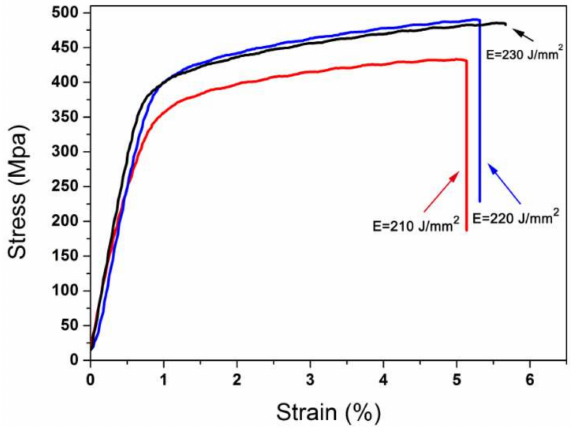
Figure 3. Tensile stress-strain cures of samples in different laser energy